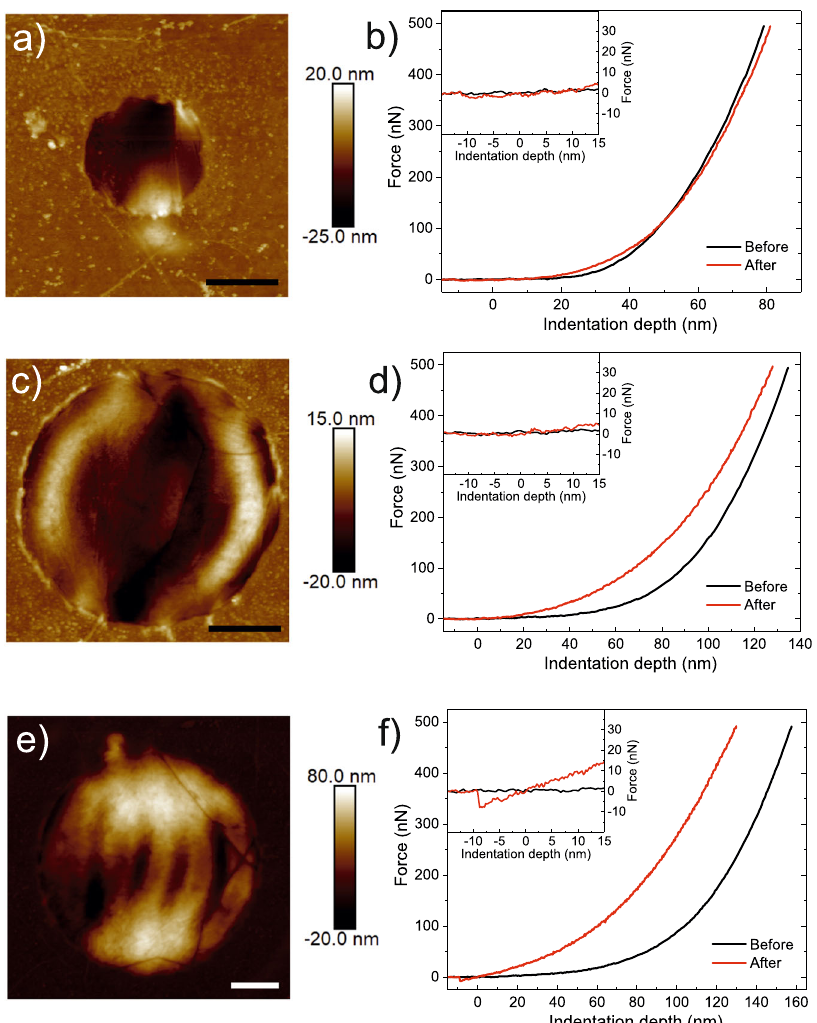
Fig. 3 AFM images and force-indentation curves for three different membranes. Irradiation dose for membranes in a and c was 4.8 · 10 10 pJscm − 2 per point and for e 7.2 · 10 10 pJscm − 2 . Panels on the right show the force-indentation curves of the membranes shown in the left, respectively. Curves are measured both before (black) and after (red) optical forging. Insets in the panels on the right show the snap-to- contact region. All the scale bars are 500